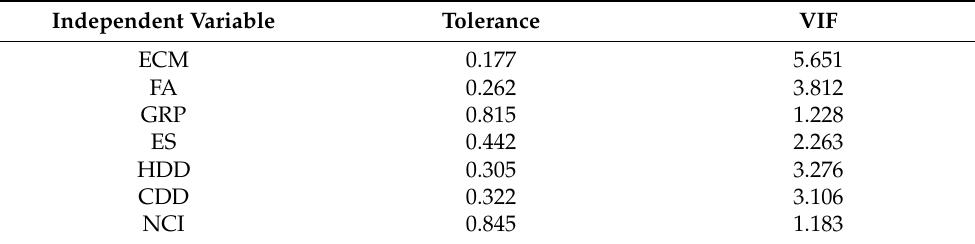
Table 2. Collinearity diagnostics for the PLSR of 250 m buffer zone.